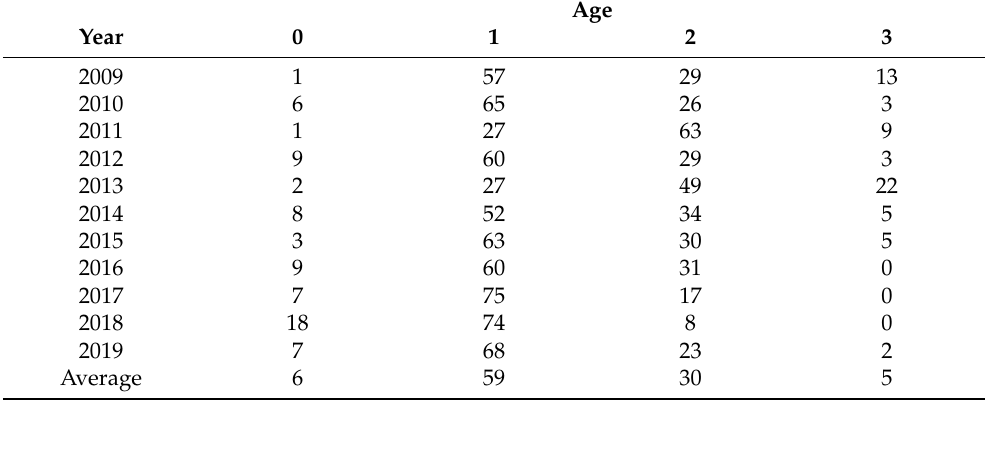
10.012.014.016.018.020.0